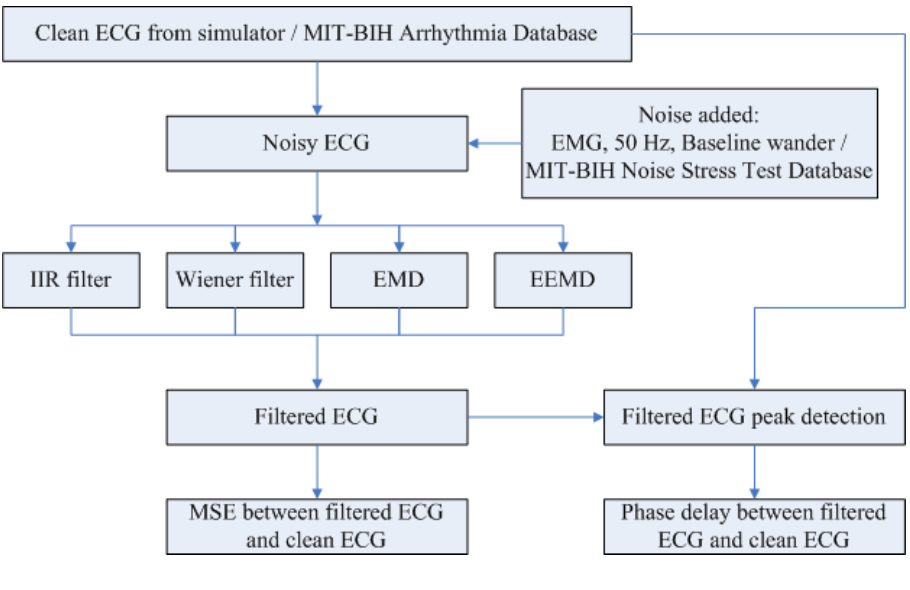
Figure 1. Flowchart of this